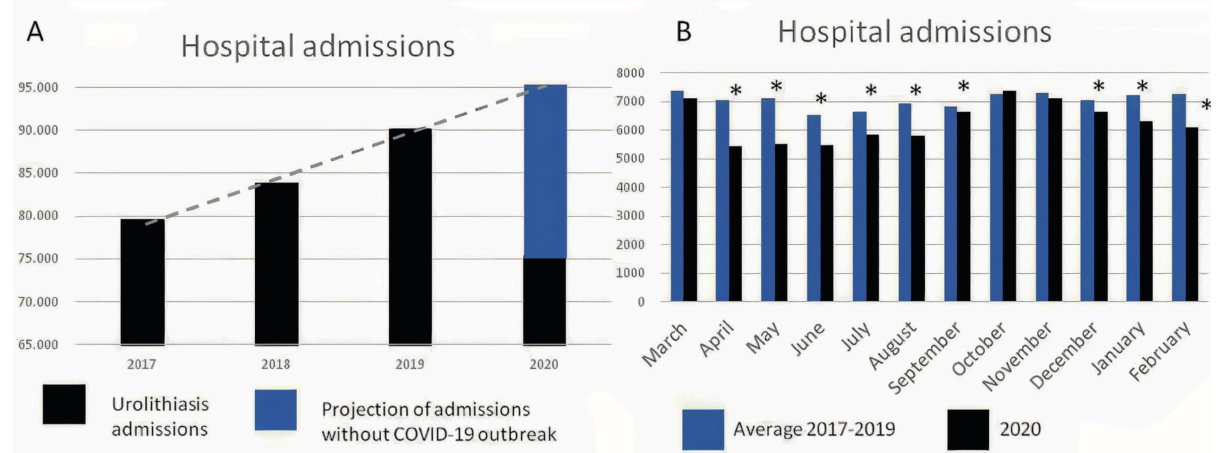
Figure 1 - Hospital admissions for urolithiasis from March 2017 to February 2021. A. In blue, projection of admissions growth without the COVID-19 pandemic. B. Monthly comparison between the average number of cases between 2017-2019 and from March 2020 to February